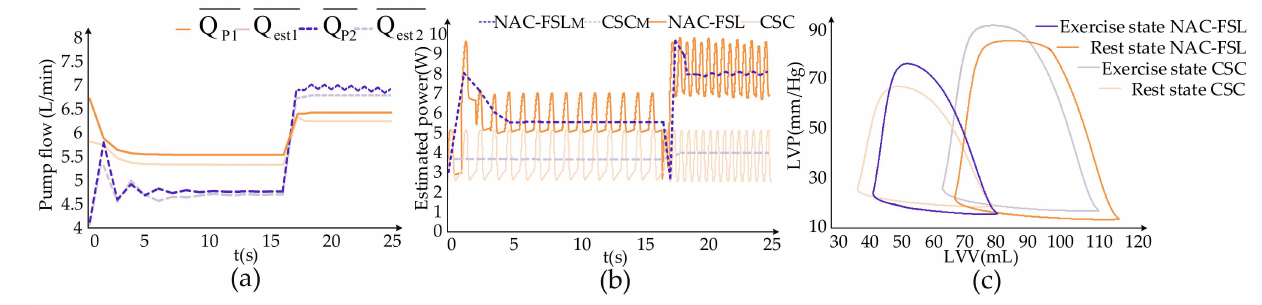
Figure 4. Effect of CSC control system and NAC-FSL control system on hemodynamic parameters from resting to exercise state. ( a ) The measured and estimated mean pump flow in two states. Q P1 and Q P2 represent the measured mean pump flows of CSC and NAC-FSL, respectively. Q est1 and Q est2 represent the estimated mean pump flows of CSC and NAC-FSL, respectively. The error between the estimated mean pump flow and the measured mean pump flow was compared. ( b ) The estimated power corresponding to the motor speed from resting to exercise. NAC-FSL M represents the mean pump power at a variable speed and CSC M represents the mean pump power at a fixed speed. ( c ) Changes in the P-V loops of the two control